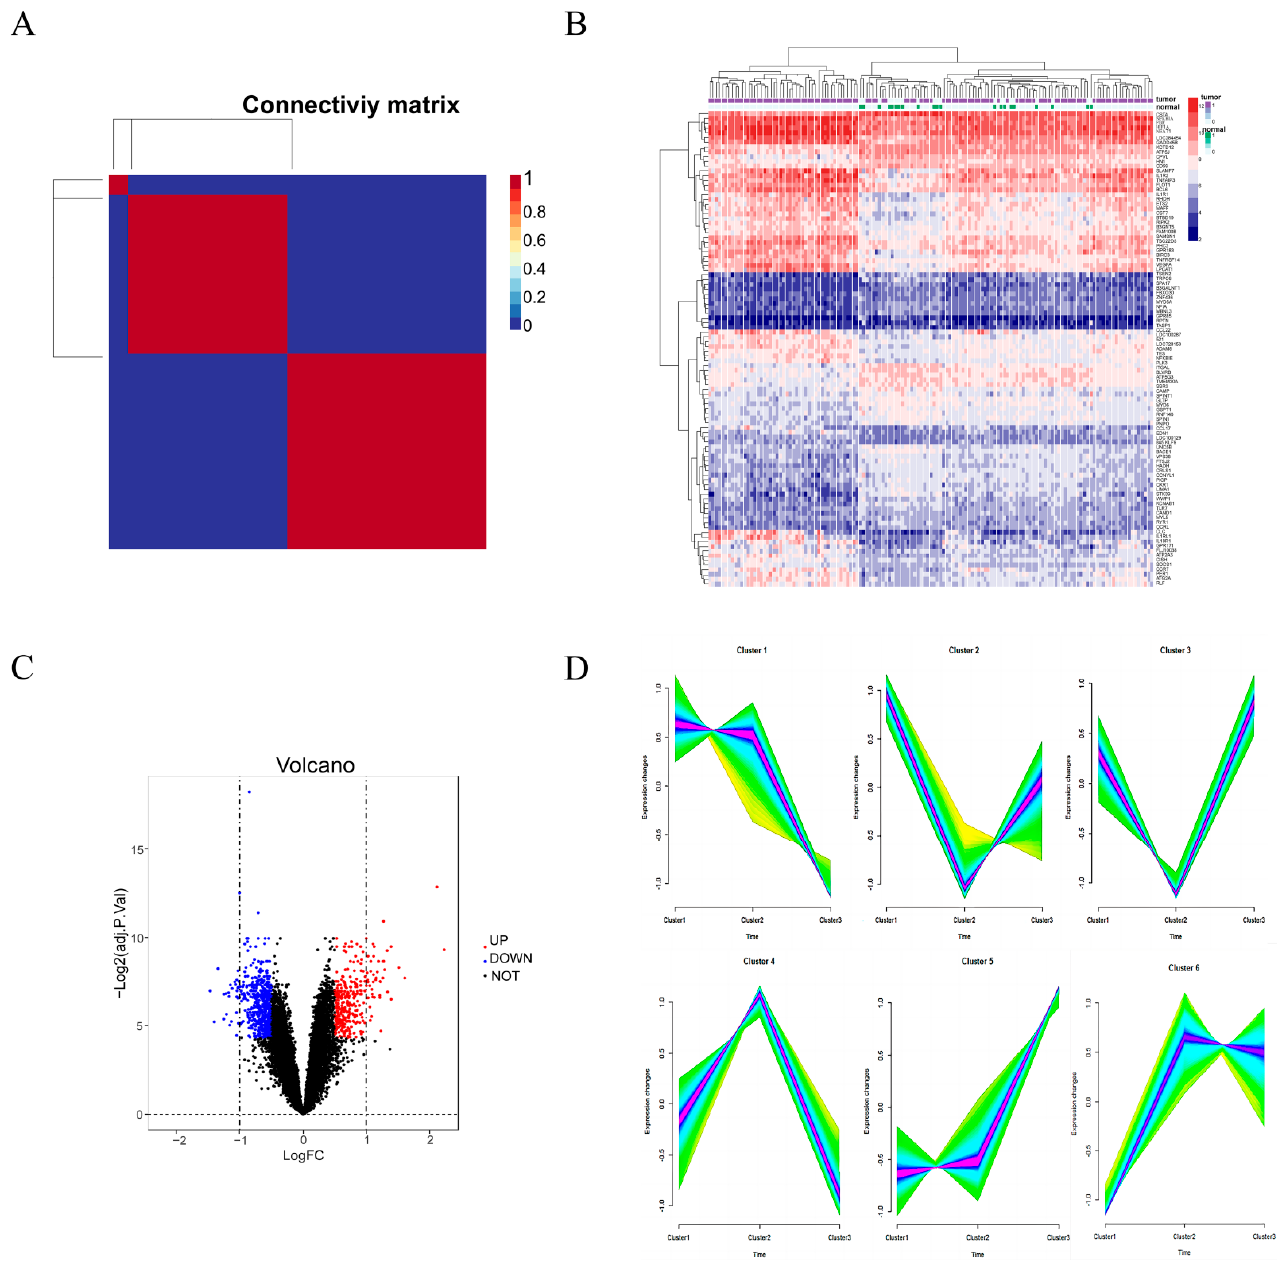
Figure 1. Differential expressed genes analysis. ( A ) Consensus map of NMF clustering. ( B ) The heatmap shows the expression of the 100 most differentiated genes in individuals. Green is the normal group, purple is the tumor group; the blue square represents low expression and the red square represents high expression. ( C ) The volcano plot shows upregulated and downregulated genes. ( D ) Fuzzy c-means clustering identified time series patterns of expression for the three clusters. The x -axis represents the three clusters, while the y -axis represents the normalized intensity ratio of log2 turns for each stage.